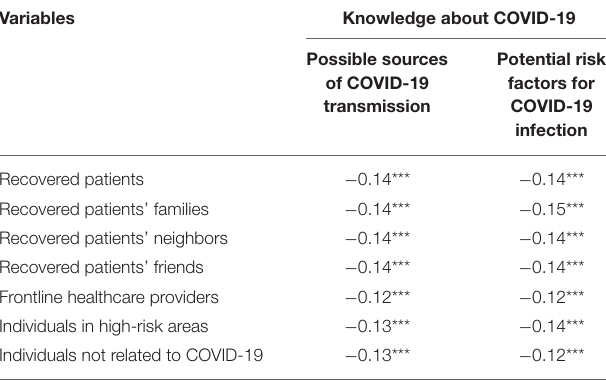
TABLE 5 | Correlations between the knowledge about COVID-19 and the COVID-19-related stigma ( N = 1,920).